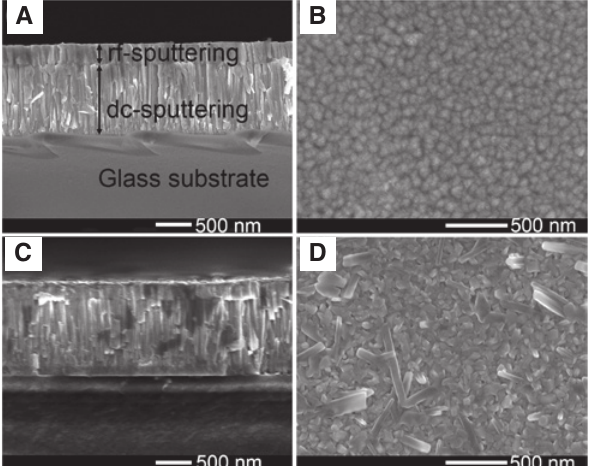
FIgure 7: SEM cross-section and surface images of DC-sputtered Mo films coated with 200-nm-thick Mo by RF-sputtering before and after selenization at 500 ° C for 20